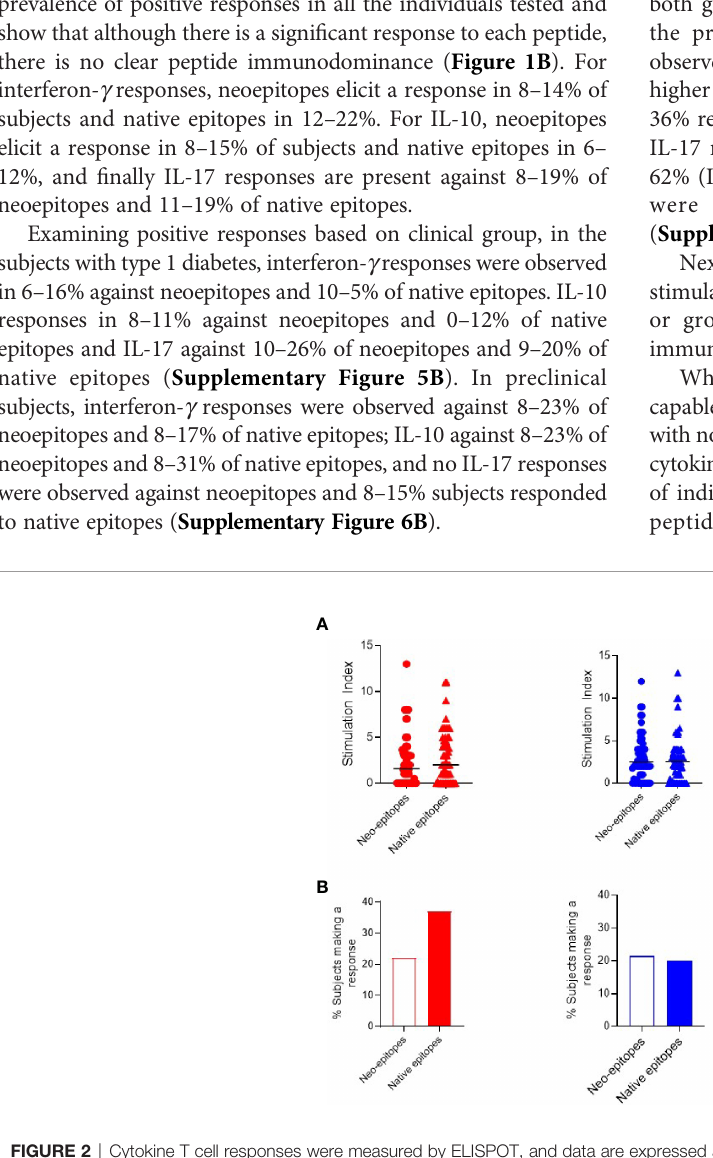
FIGURE 2 | Cytokine T cell responses were measured by ELISPOT, and data are expressed as SI [stimulation index (mean spot number of test peptide/mean spot number of diluent)]. (A) Magnitude of responses as depicted by SI for IFN- g (red) IL-10 (blue) and IL-17 (purple) responses against pooled neo- and native epitopes in preclinical and subjects with type 1 diabetes. (B) Prevalence of IFN- g (red) IL-10 (blue) and IL-17 (purple) responses in preclinical and subjects with type 1 diabetes against pooled peptides of neo- (open bars) and native ( fi lled bars)